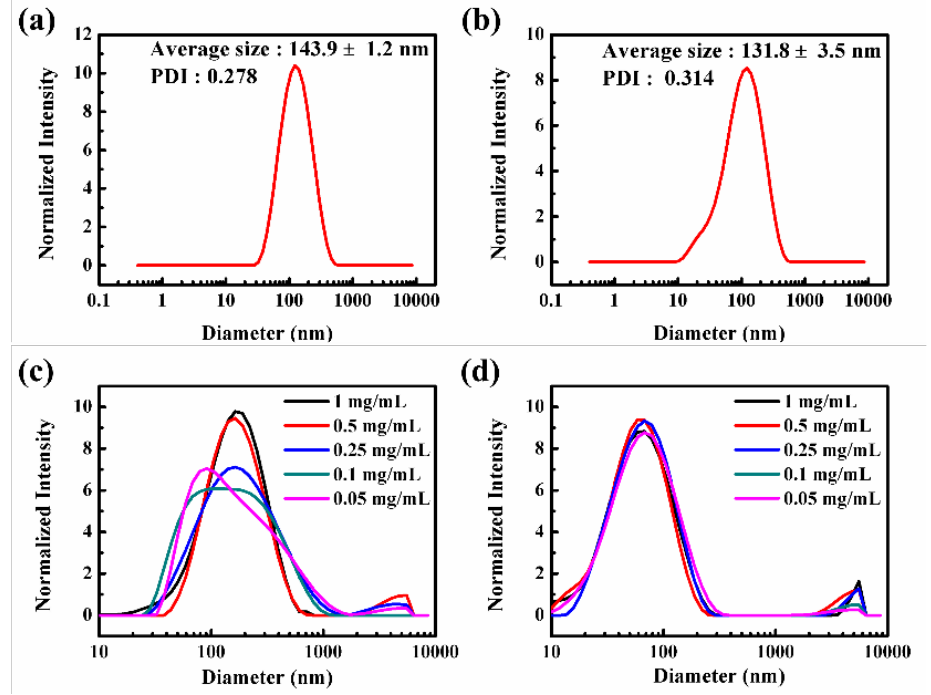
Figure 3. Size distributions of P 1 ( a ), and P 2 ( b ) micelles with a polymer concentration of 0.5 mg/mL in DMF; P 1 ( c ), and P 2 ( d ) with different polymer concentrations in water.